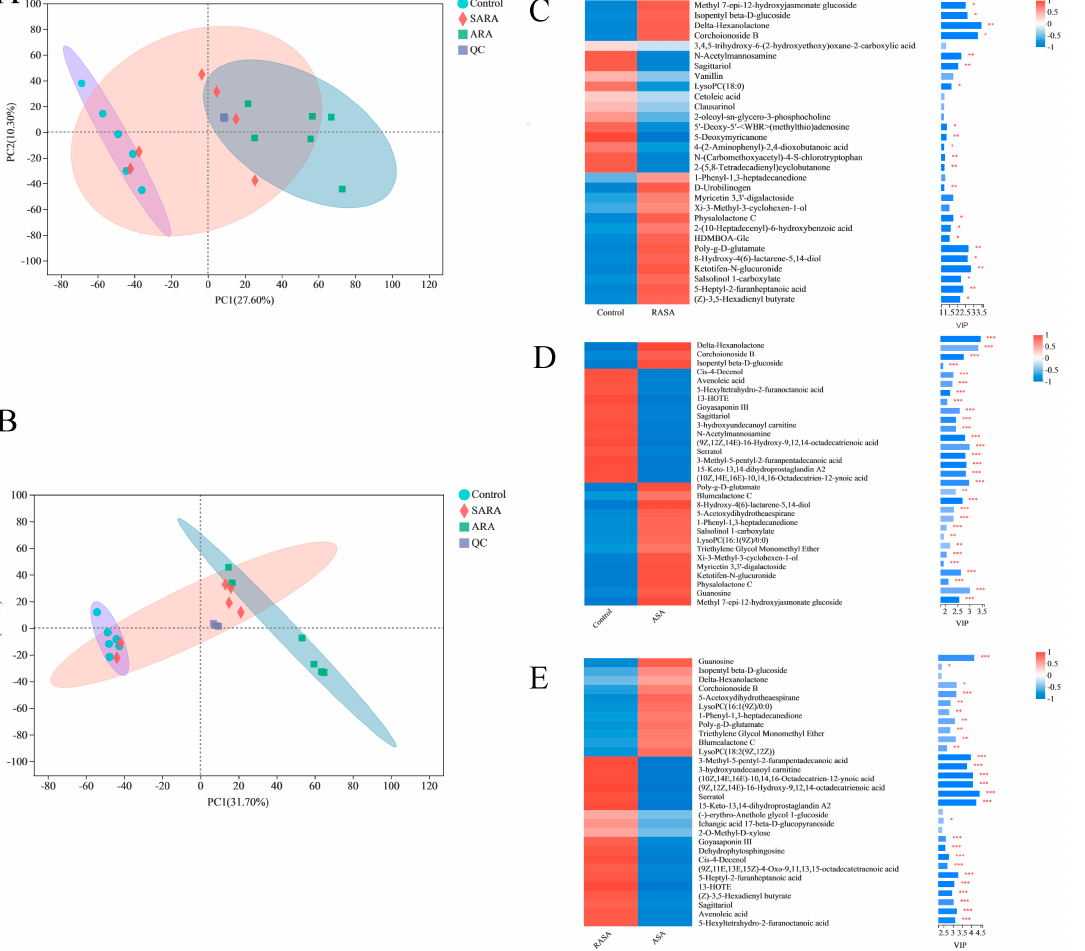
Figure 5. Principal component analysis (PCA) score plots of metabolomic data ( A , B ) and